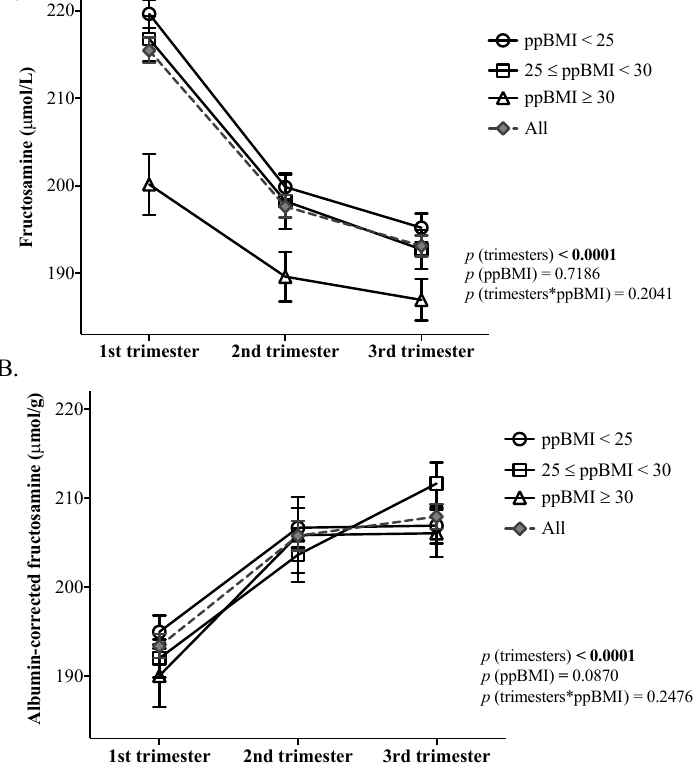
Figure 1. Circulating fructosamine and albumin ‐ corrected fructosamine concentrations across trimesters, according to pre ‐ pregnancy BMI categories . Legend. p ‐ values refer to the mixed models for repeated measures used to examine the evolution of trimester ‐ specific circulating concentrations of ( A ) fructosamine and ( B ) albumin ‐ corrected fructosamine according to ppBMI. ppBMI, pre ‐ pregnancy body mass index. n = 101.